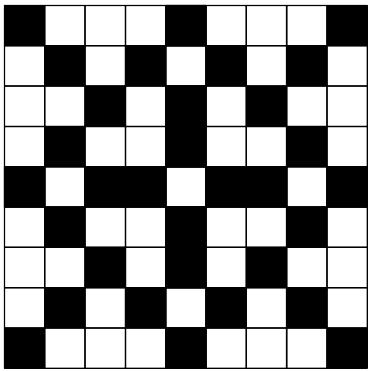
Figure 3 A symmetrical pattern on a 9  9 grid. For a single pixel, the proposed ternary census transform results in 64-bit binary codes.